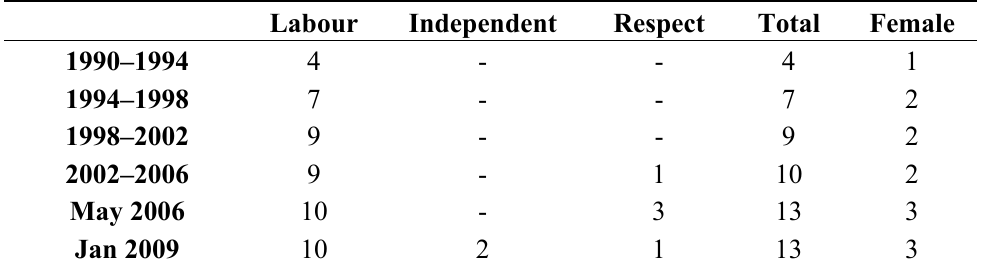
Table 3. Party Breakdown of Muslim Councilors in Newham,